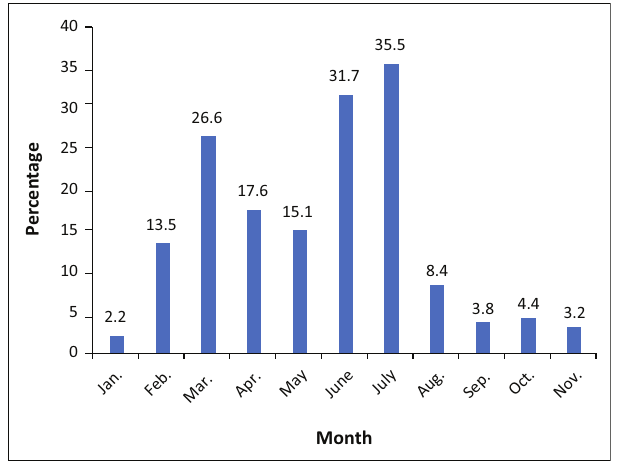
FIGURE 6: Grain marketing board prices of maize grain over the period from February 2019 to October